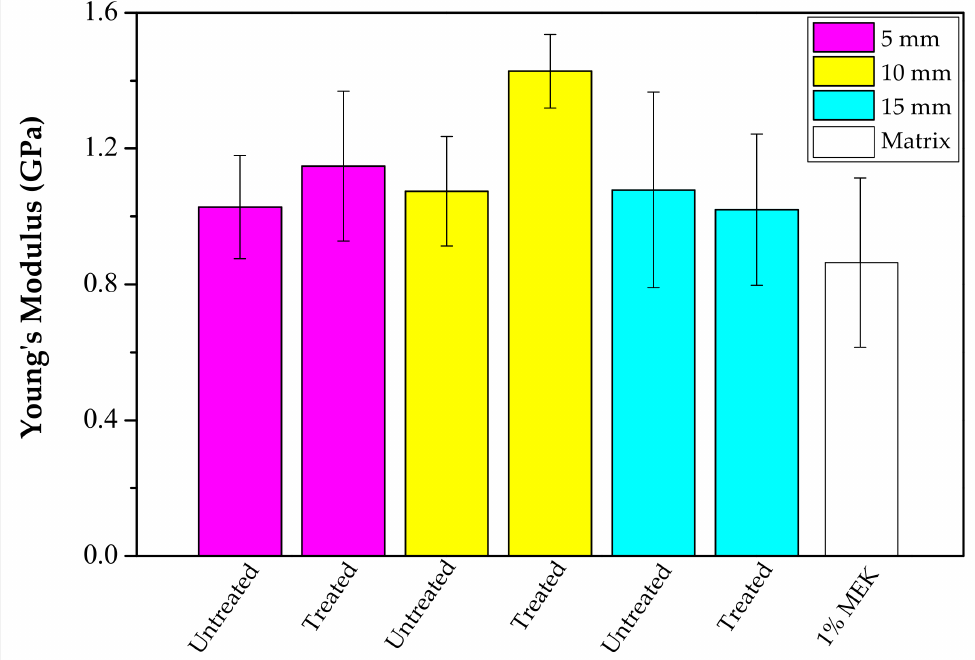
Figure 9. Young’s modulus of ra ffi a fiber composites under alkali treated and untreated conditions, with 5, 10, and 15 mm of fiber